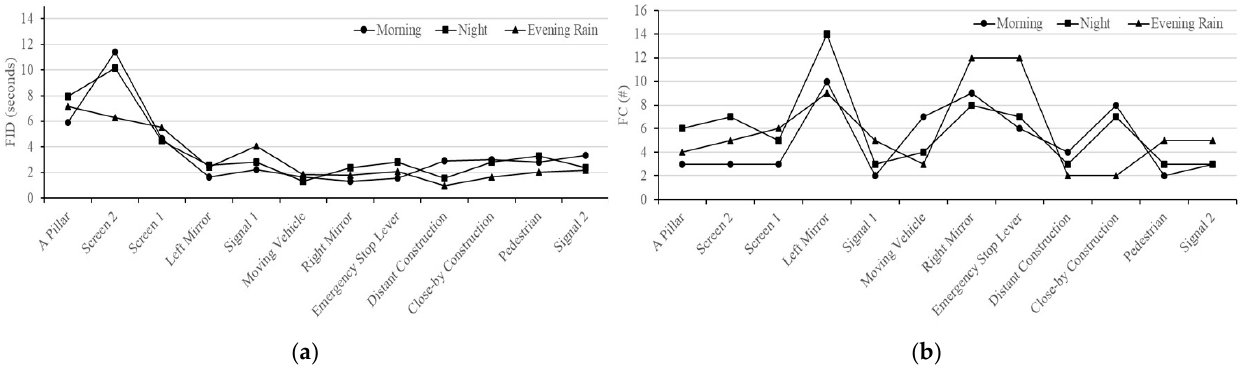
Figure 15. Comparison of Driver 1 responses in terms of ( a ) average fixation instance duration and ( b ) fixation counts for all scenarios across the three driving conditions.